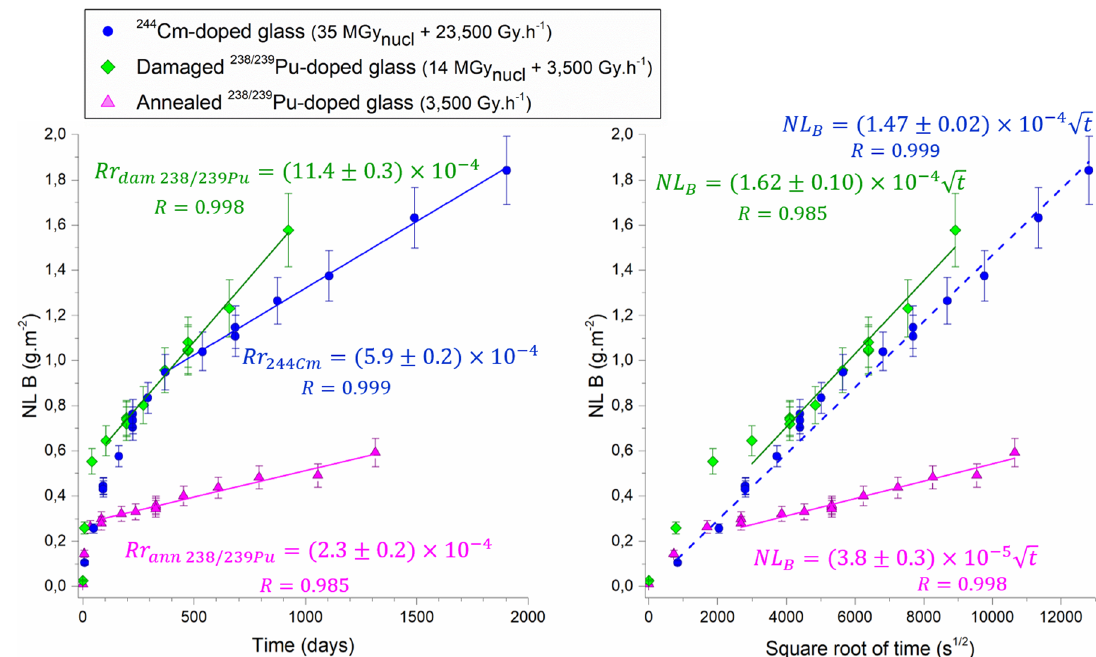
Fig. 4 Time and square root of time dependence of boron releases for the doped glass leaching tests. Boron normalized mass loss (NL B) versus time ( a ) and square root of time ( b ), with pink triangles, green diamonds, and blue circles representing annealed 238/239 Pu-doped glass, damaged 238/239 Pu-doped glass, and 244 Cm-doped glass, respectively. In ( a ), the residual alteration rate values (Rr) associated with each experiment are given (with the relative Pearson ’ s R -value) and expressed in g m − 2 d − 1 . In ( b ), NL B versus √ t can be linearly fi tted, either passing through the origin (dashed line) or with a positive y-intercept (solid lines). Error bars are of ±10% and their calculation is detailed in the “ Solution analyses ”